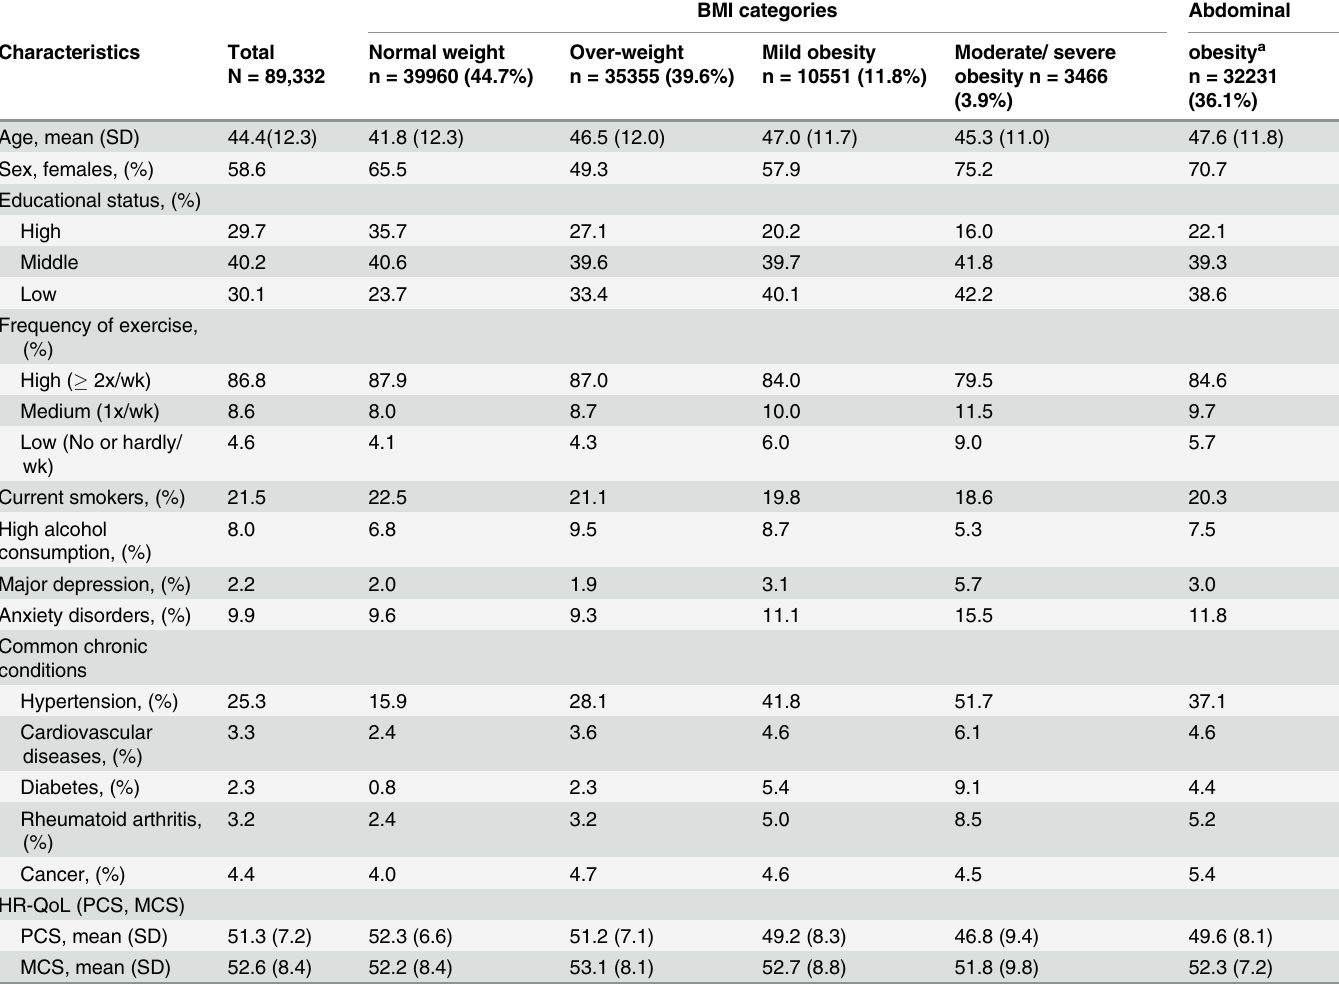
Table 1. LifeLines cohort characteristics by BMI categories and abdominal